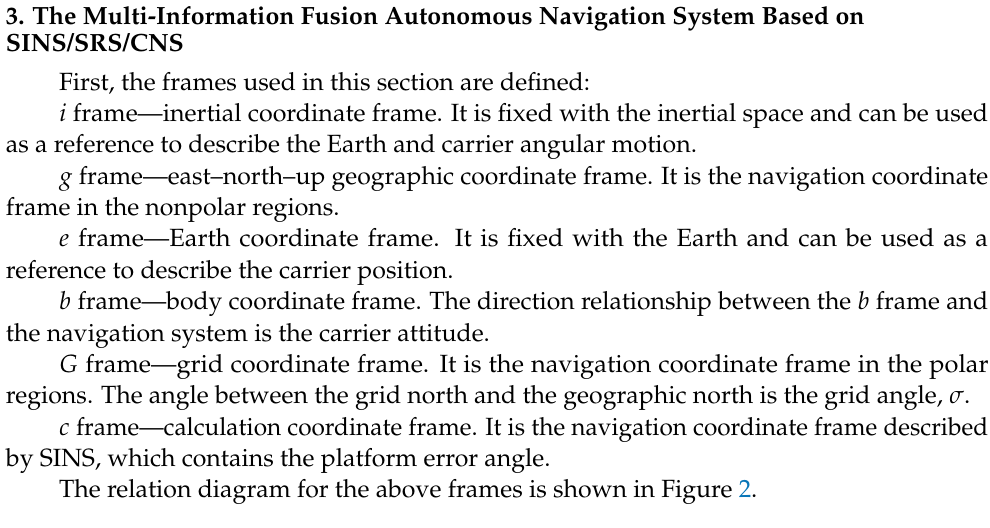
Figure 1. The multi-information fusion global autonomous navigation scheme diagram for UAVs.